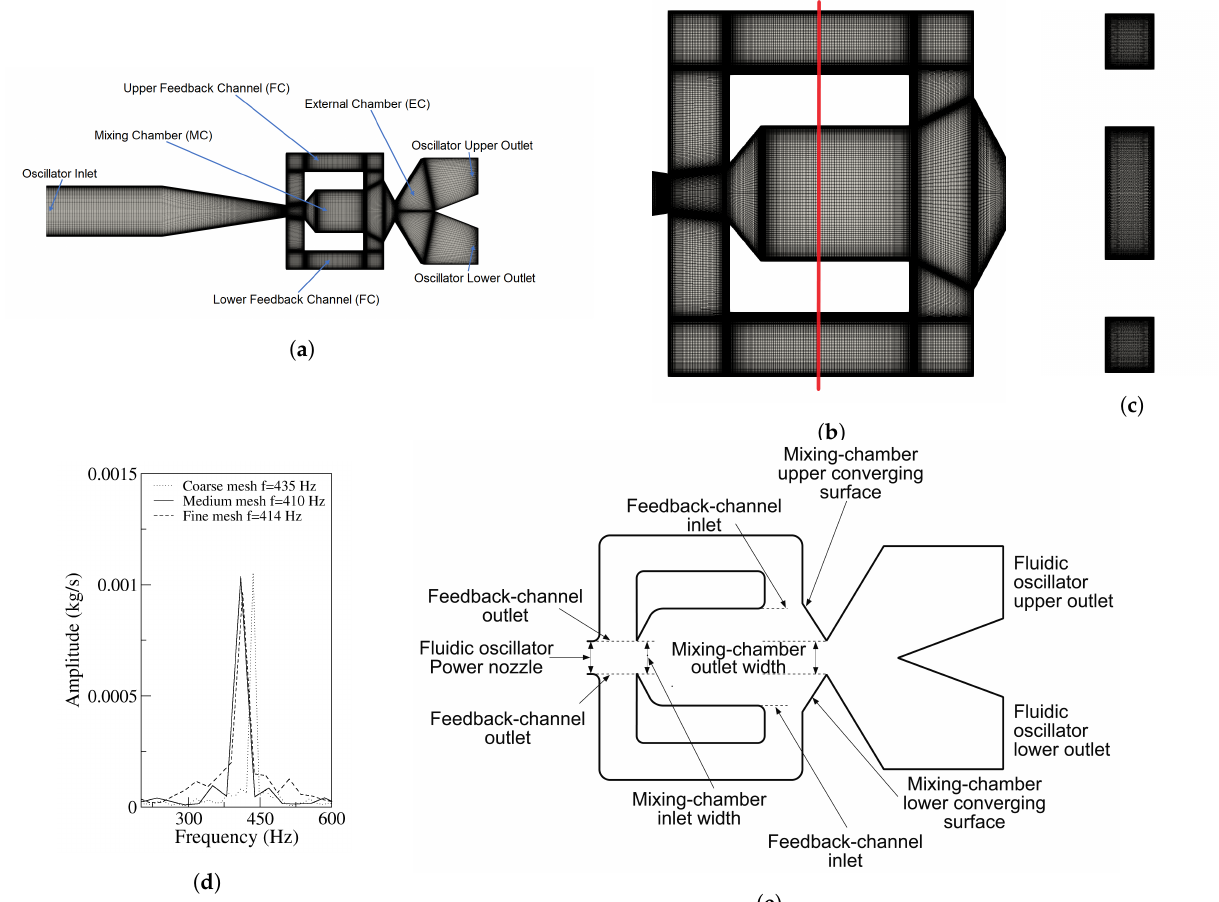
Figure 1. ( a ) Fluidic oscillator mesh, main view; ( b ) mixing chamber computational domain; ( c ) mesh side view; ( d ) fluidic oscillator outlet frequency for the three meshes studied; ( e ) mixing chamber main